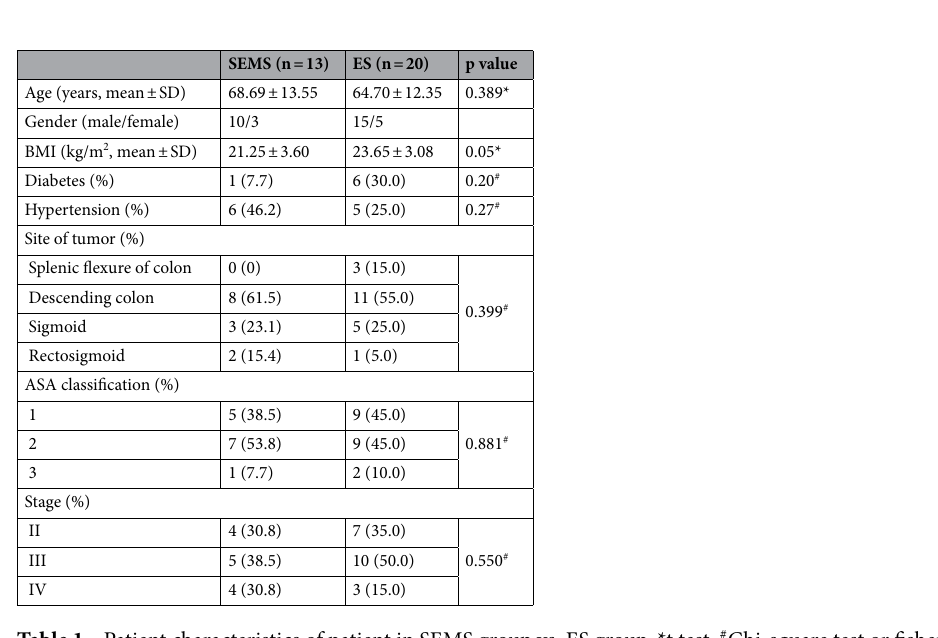
Table 1. Patient characteristics of patient in SEMS group vs. ES group. *t test. # Chi-square test or fisher’s exact